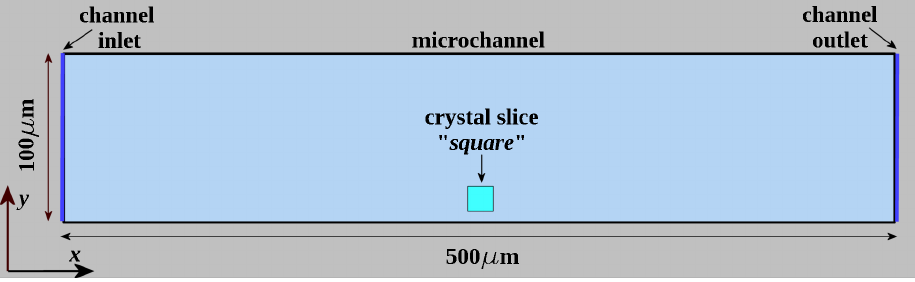
Figure 7. Geometry of channel and crystal.